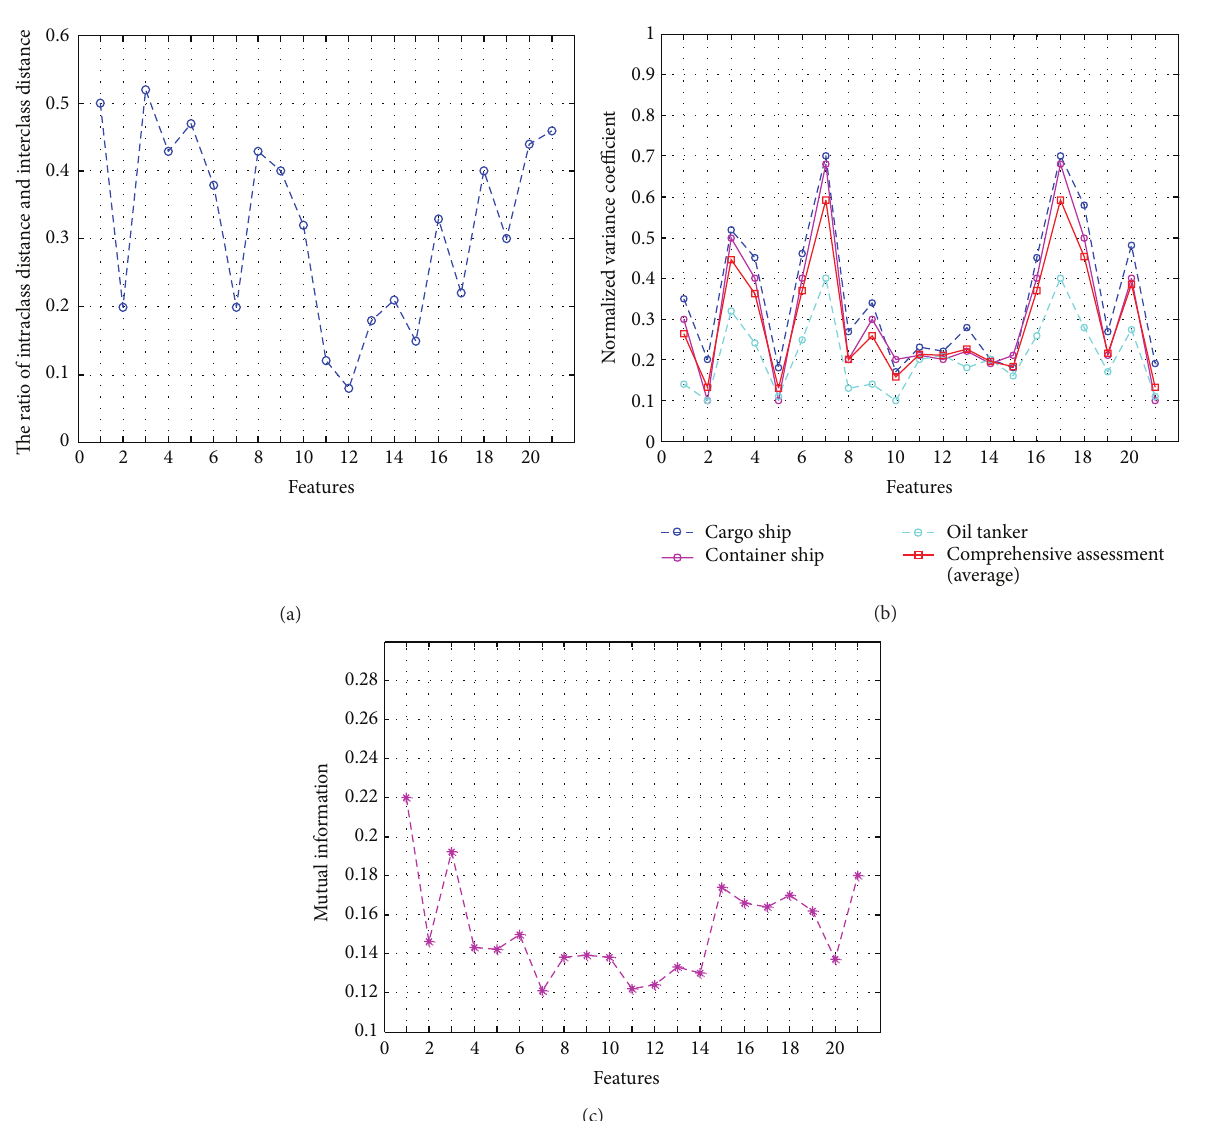
Figure 5: Analysis of feature attribute. (a) Discriminability (the ratio of intraclass distance and interclass distance), (b) stability (normalized variance coefficient), and (c) BIF (mutual information).